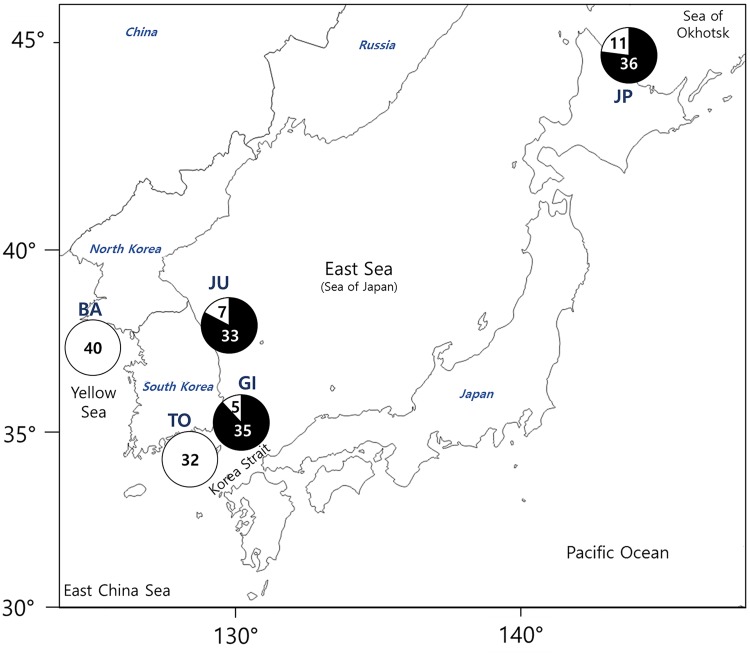
Map showing the occurrence ratio of each lineage in Korean and Japanese sand lance.Four locations in Korea: BA (Baengnyeongdo, n = 40), TO (Tongyeong, n = 32), GI (Gijang, n = 40), JU (Jumunjin, n = 40), and one location in Japan: JP (Wakkanai, n = 47). Open and solid circles indicate southern lineage (SOL) and northern lineage (NOL), respectively.